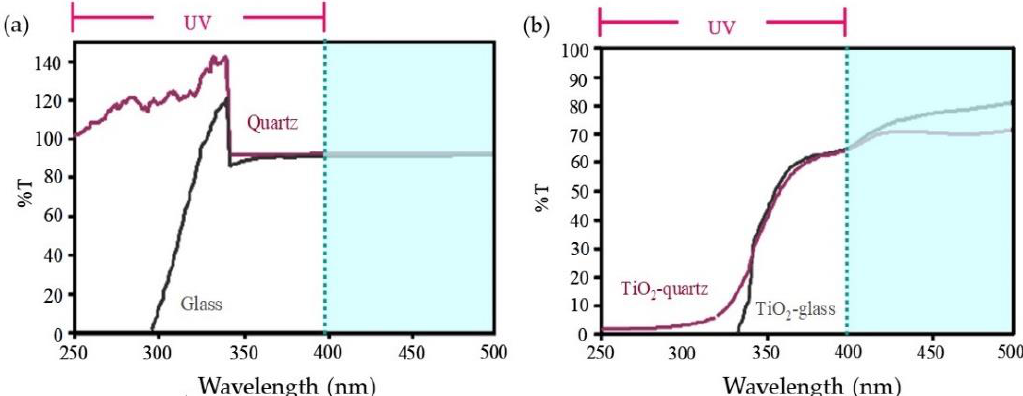
Figure 2. UV–Vis spectra of ( a ) raw quartz and glass, and ( b ) TiO 2 film deposited on quartz, and glass by repeating 3 coating cycles.